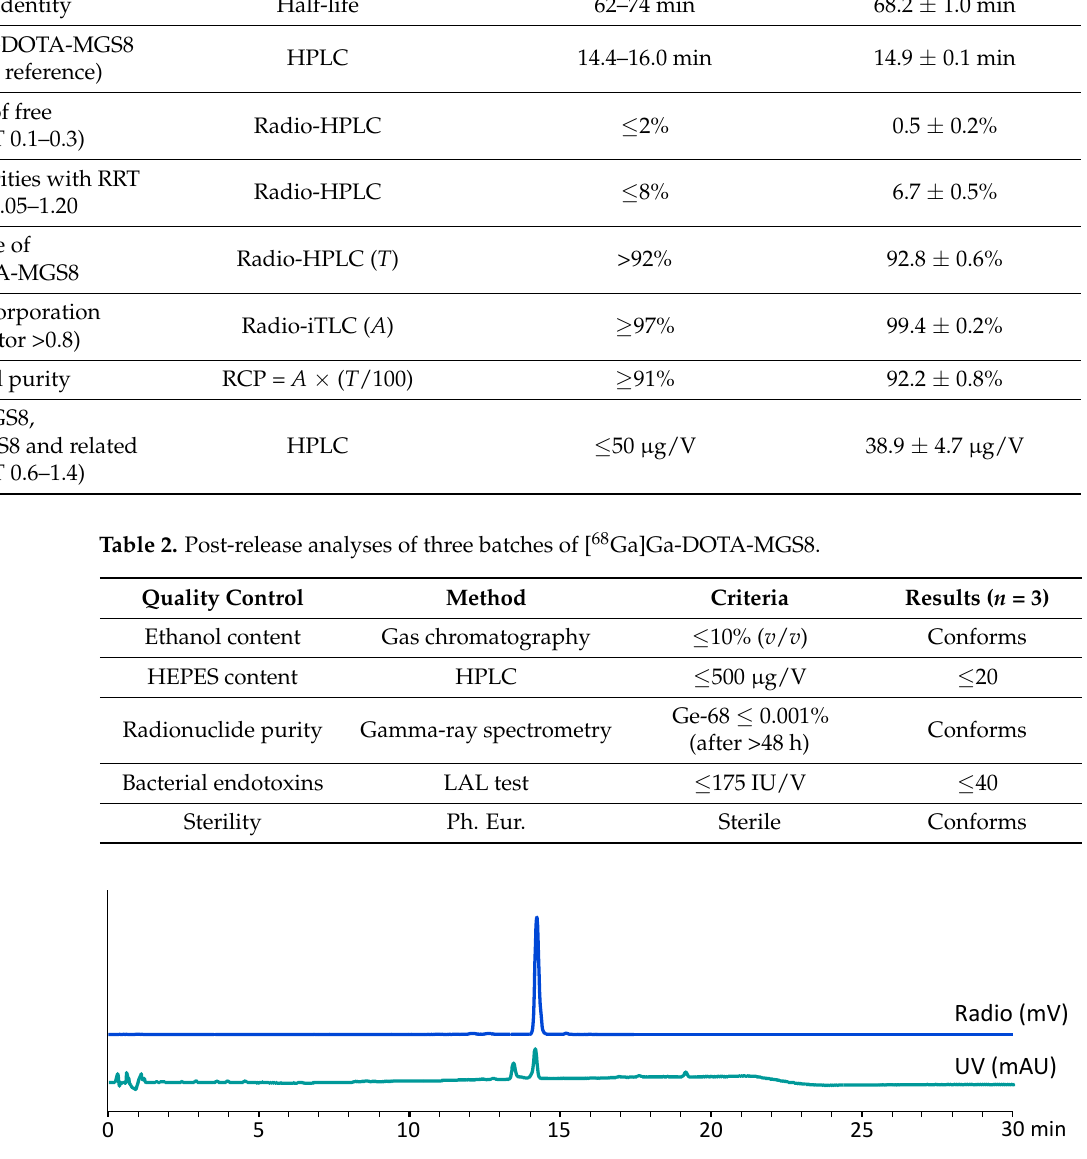
Figure 3. Representative radio-HPLC and UV-chromatogram of [ 68 Ga]Ga-DOTA-MGS8.